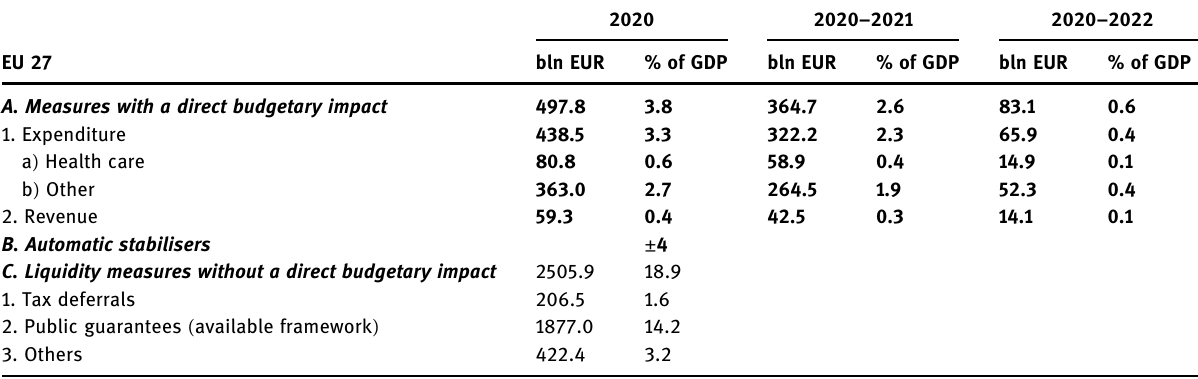
Table 5: Overview of national fi scal - budgetary measures in response to the COVID - 19